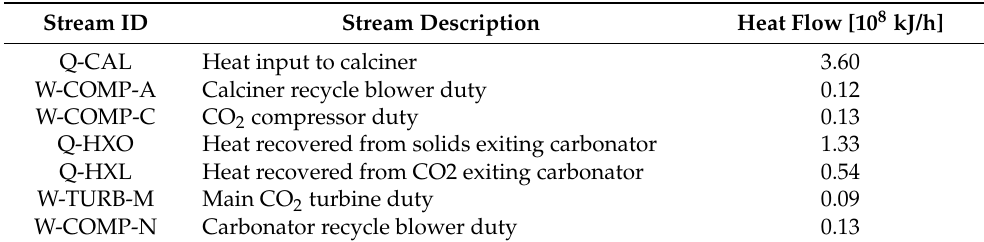
Table A2. Configuration 1 base case energy input and recovery summary.